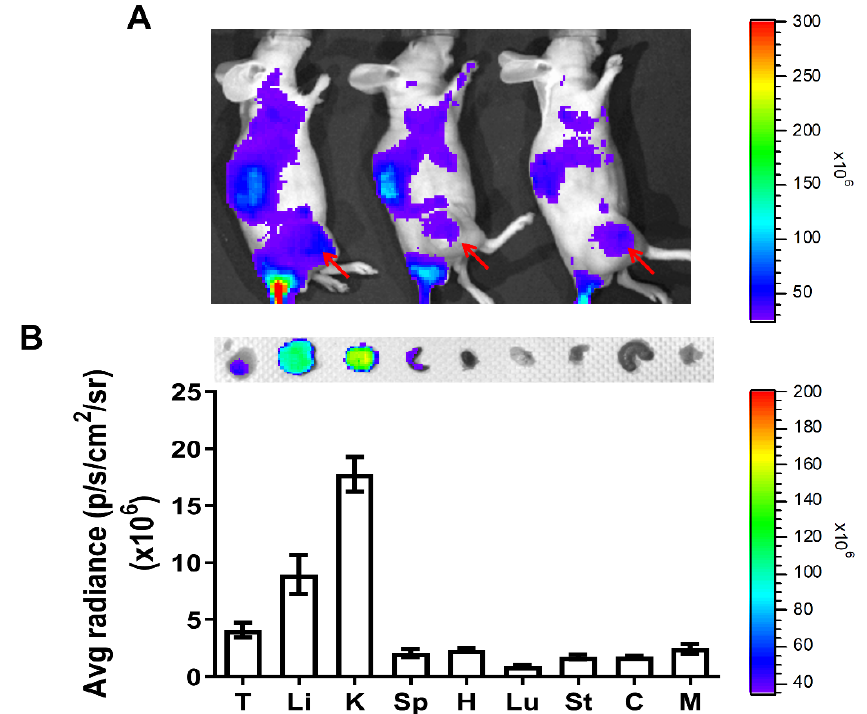
Figure 1. Bio-distributions of bovine serum albumin–coated gold nanoparticles (GNPs–BSA) in gastric cancer xenografts. To measure the tissue distributions of GNPs–BSA nanoparticles, the Cy7.5 pre-labeled GNP–BSA were intravenously injected into animals for 48 h and then analyzed by using in vivo imaging system (IVIS). The images revealed that fluorescent GNPs–BSA nanoparticles were not only distributed in tumors located on the right thigh, but also in other regions, as shown in ( A ). The fluorescent intensity in the major organs, including liver (Li), kidney (K), spleen (Sp), heart (H), lung (Lu), stomach (St), colon (C), and muscle (M), was also measured and compared. Quantitative data were determined by the valve of fluorescent intensity/tumor volume ( n = 3). Average radiance values of GNPs–BSA in the organs and tumors shown in ( B ). p/s/cm 2 /sr: photons per second per square centimeter per